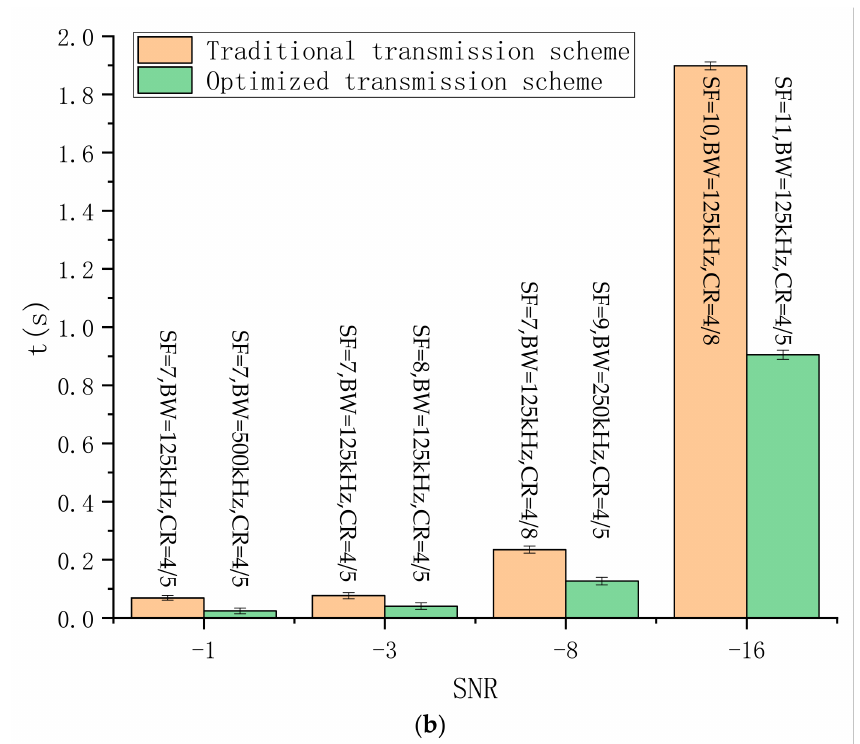
Figure 13. Transmission time t for different parameter configurations. The lower the (t), the better. ( a ) shows result of the average time required for each packet to be successfully transmitted; ( b ) shows the result of the transmission time when the packet length is 32 bytes with different